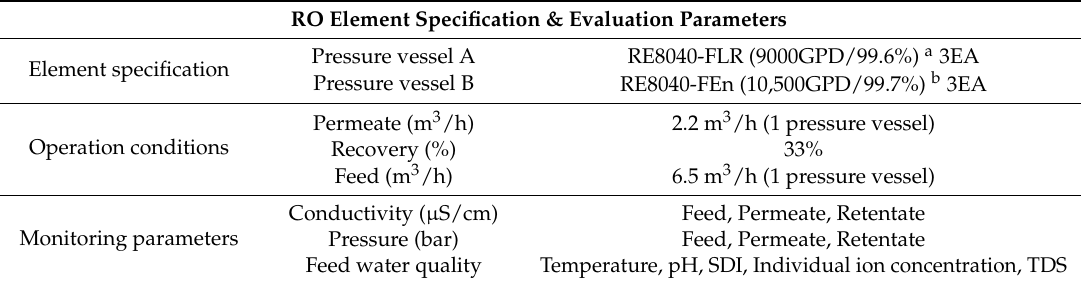
Table 1. Detailed descriptions on the reverse osmosis (RO) elements and monitoring